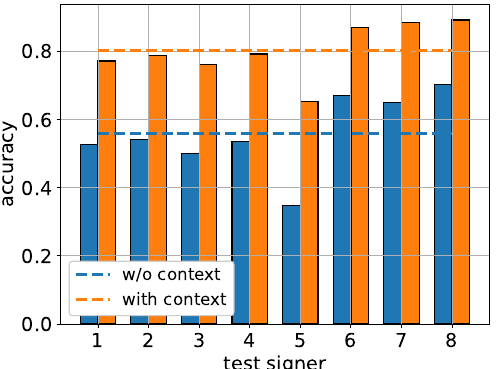
Figure 5. Top-3 accuracy using D 1 as the distance metric, for k =